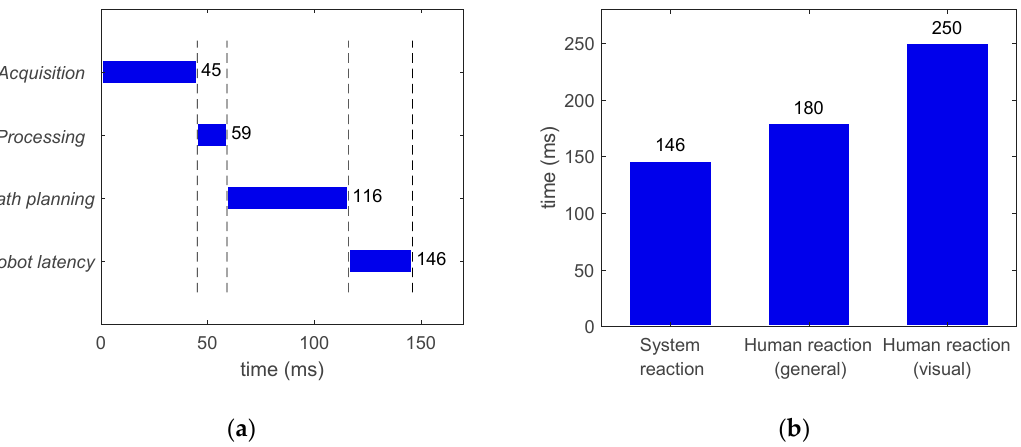
Figure 21. Approximated average reaction times: ( a ) The proposed system including machine vision (acquisition, processing), path planning and robot latency in sequential implementation (times do accumulate); ( b ) A comparison between the proposed system, the general human reaction time [20] and the visual human reaction time [44].